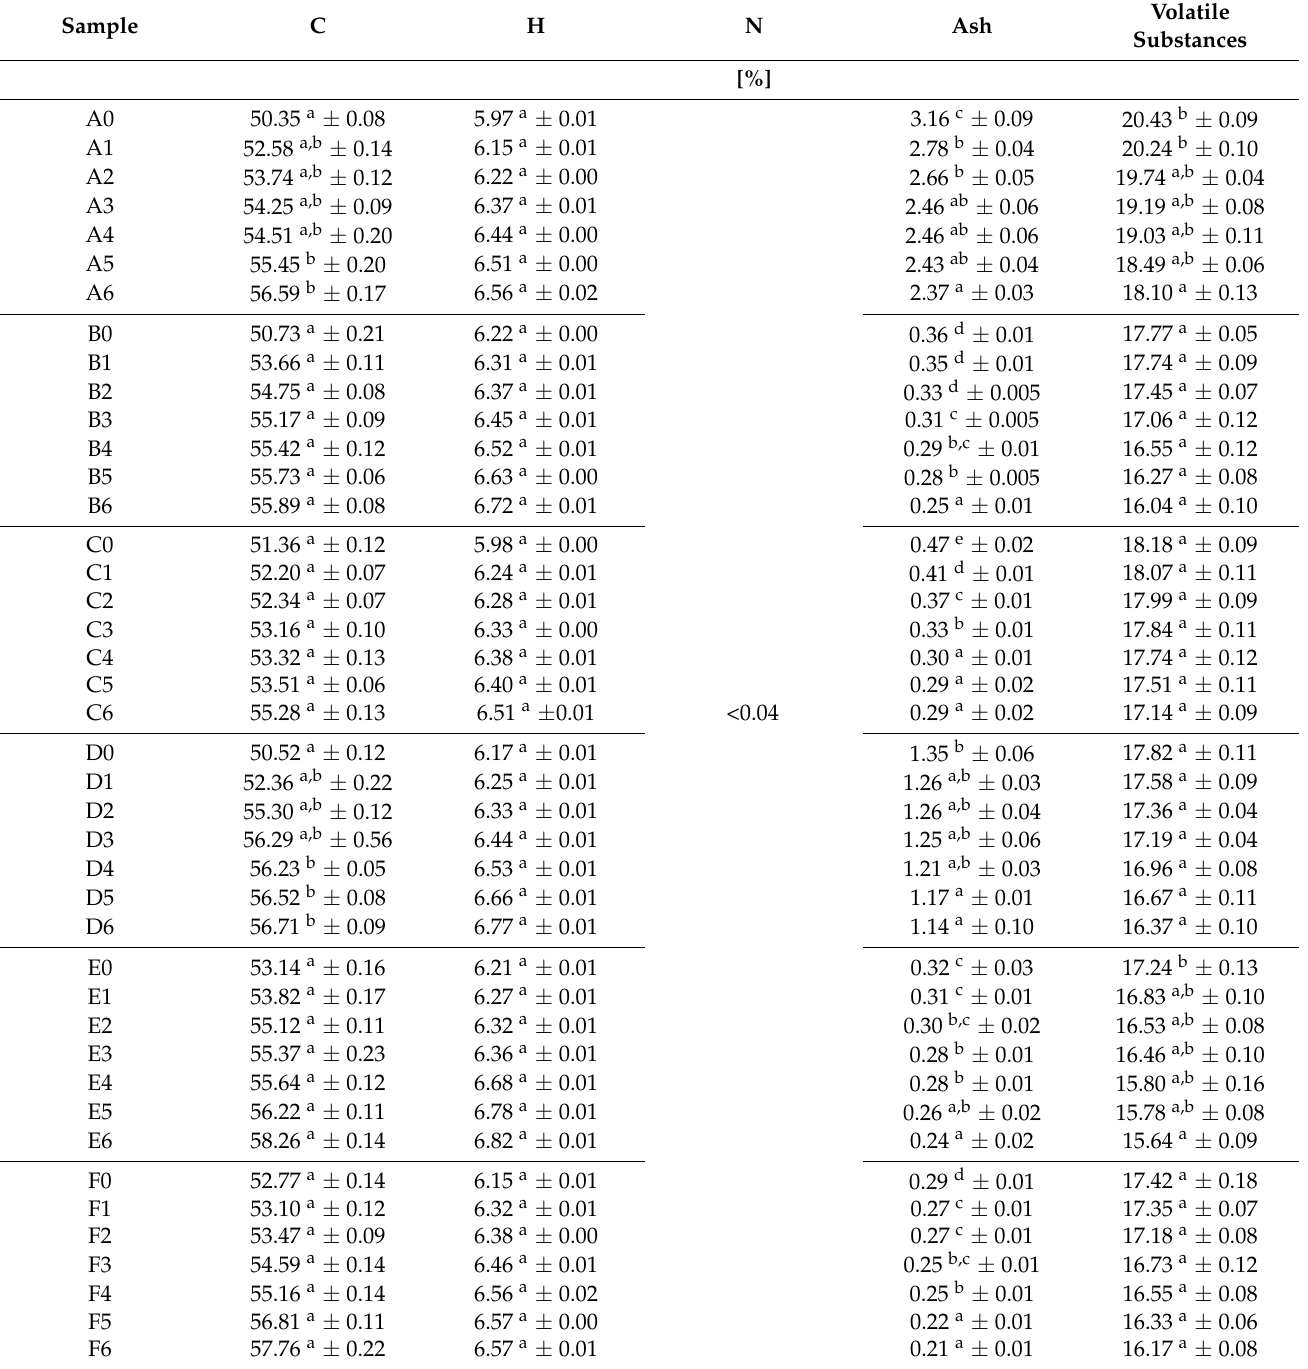
Table 3. Contents of total nitrogen, total carbon, hydrogen, ash, and volatile substances in selected pellets, before and after waste cooking oil was added by